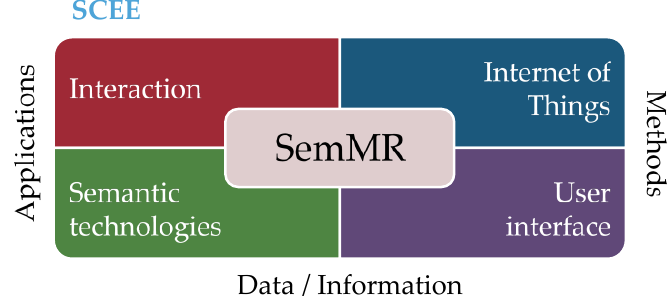
Figure 1. The shared cultural experience ecosystem (SCEE).